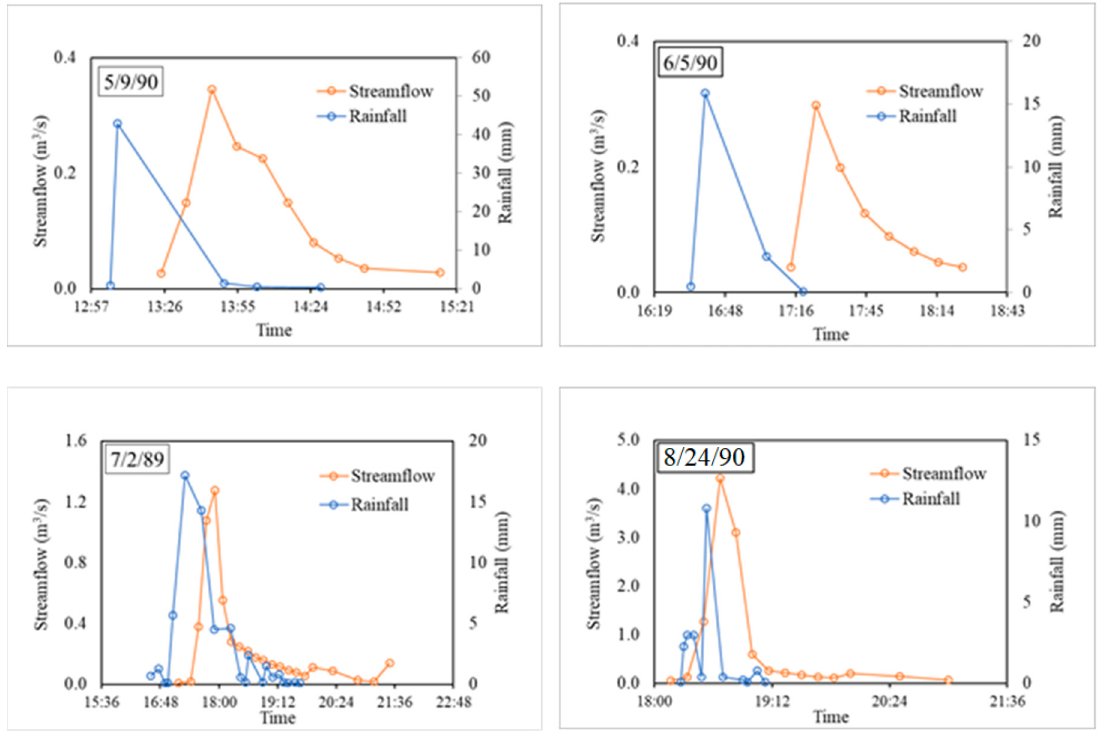
Figure 7. Event rainfall-runoff relationships for selected storm events from the Anjeni watershed.